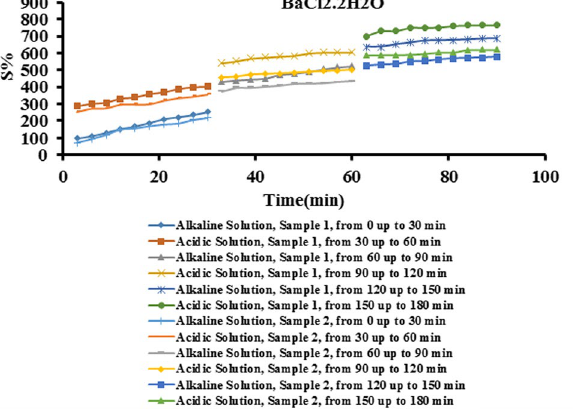
Fig. 8 Swelling changes in samples 1 and 5 in acidic and alkaline BaCl 2 ·2H 2 O salt solutions over